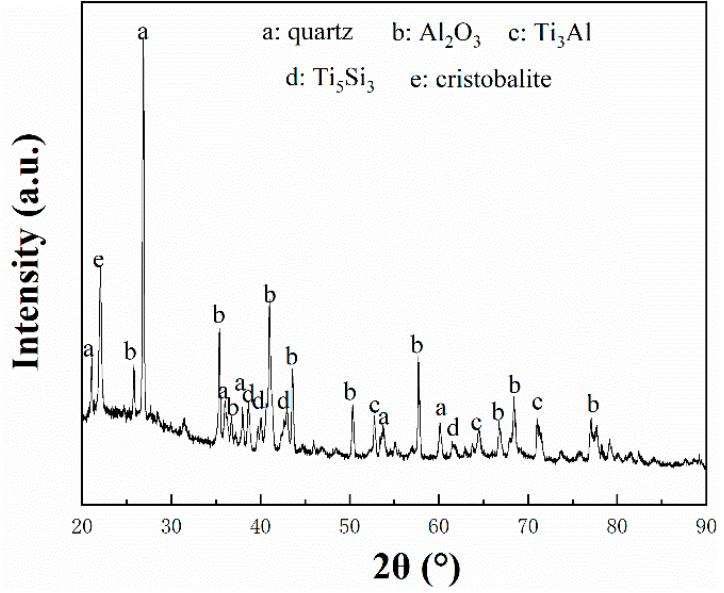
Figure 6. XRD patterns of the SiO 2 ‐ Al 2 O 3 glass composite coating after corrosion in marine environ ‐ ◦ ment for 100 h at 650 °C. ment for 100 h at 650